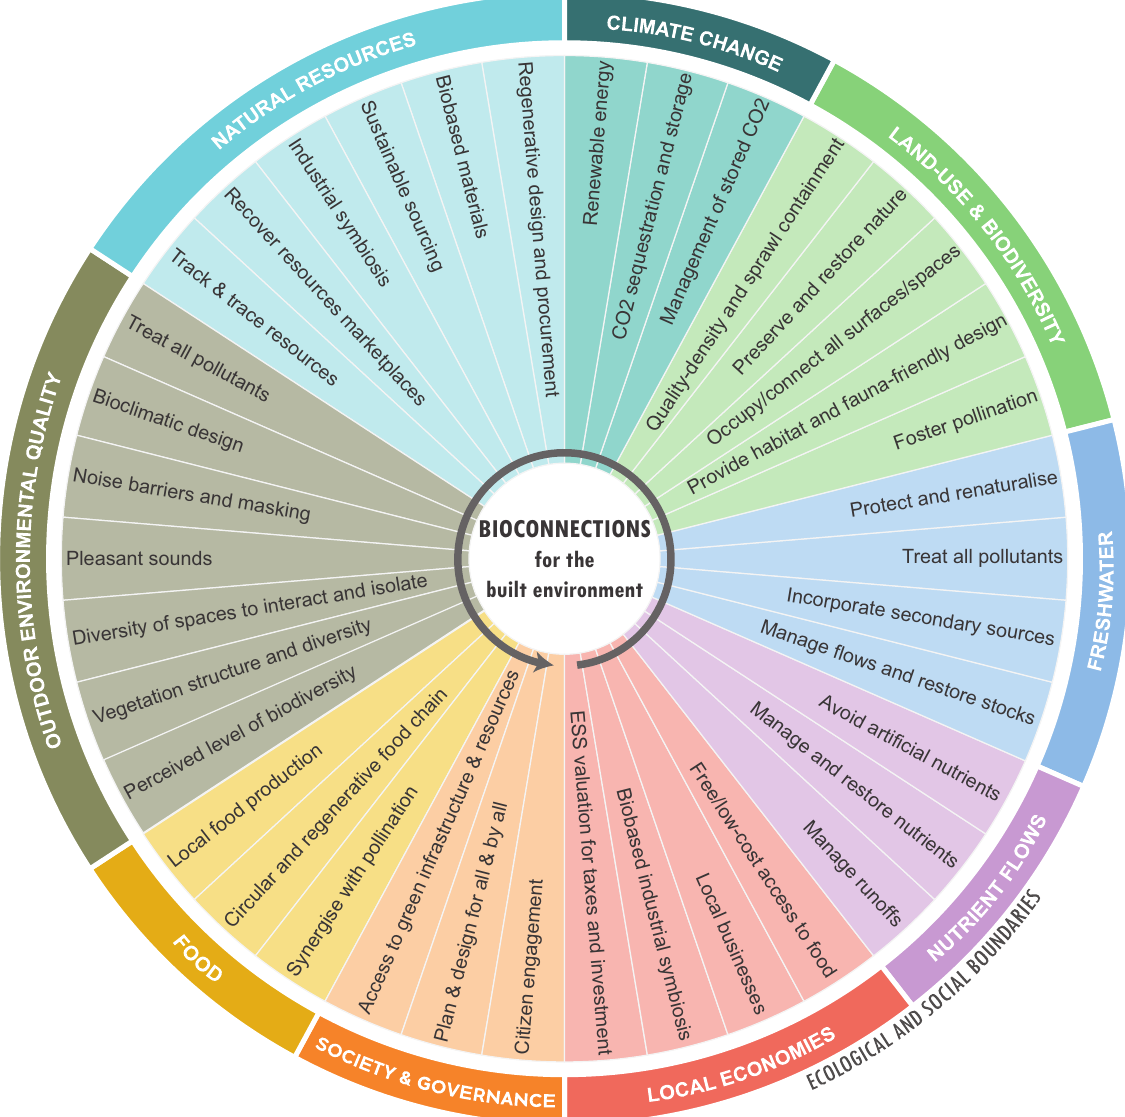
Figure 9. Bioconnections framework for ecological and social boundaries under a regenerative and circular approach for the built